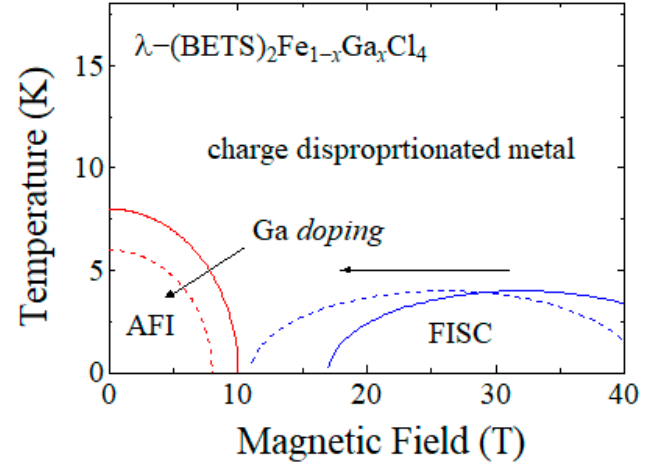
Figure 1. Schematic field-temperature phase diagram of λ -(BETS) 2 Fe 1 − x Ga x Cl 4 , showing the effect of Ga doping.